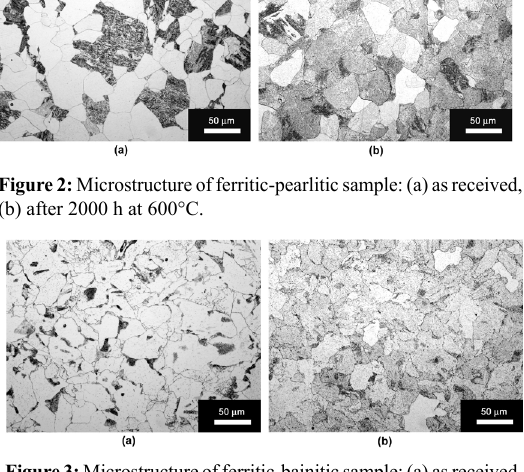
Figure 3: Microstructure of ferritic-bainitic sample: (a) as received, (b) after 2000 h at